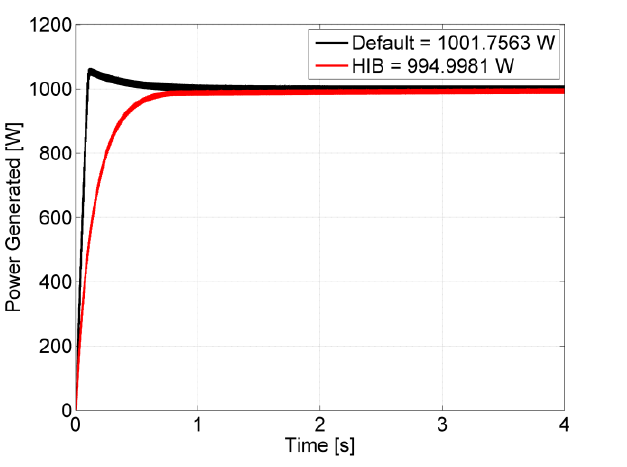
Fig. 13. SRG output power after hybrid GA